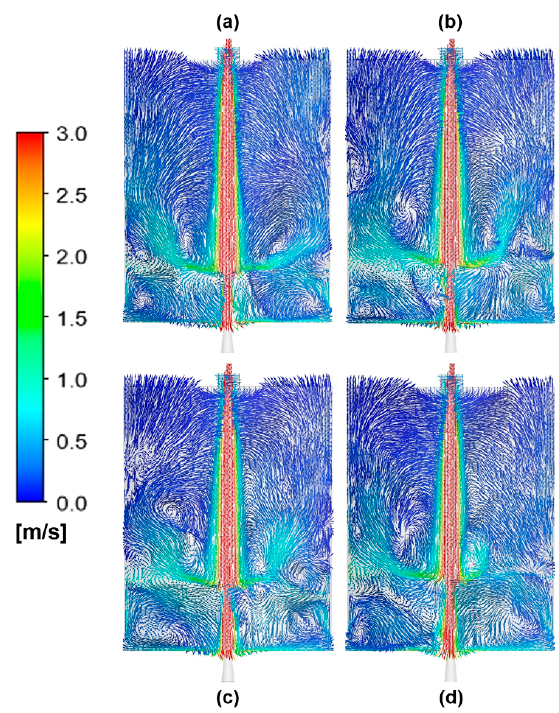
Figure 5. ( a – d ) Unsteady fields of velocity in the central plane during ladle filling from 16 to 30 tons. Each figure shows a time step of 10 s.